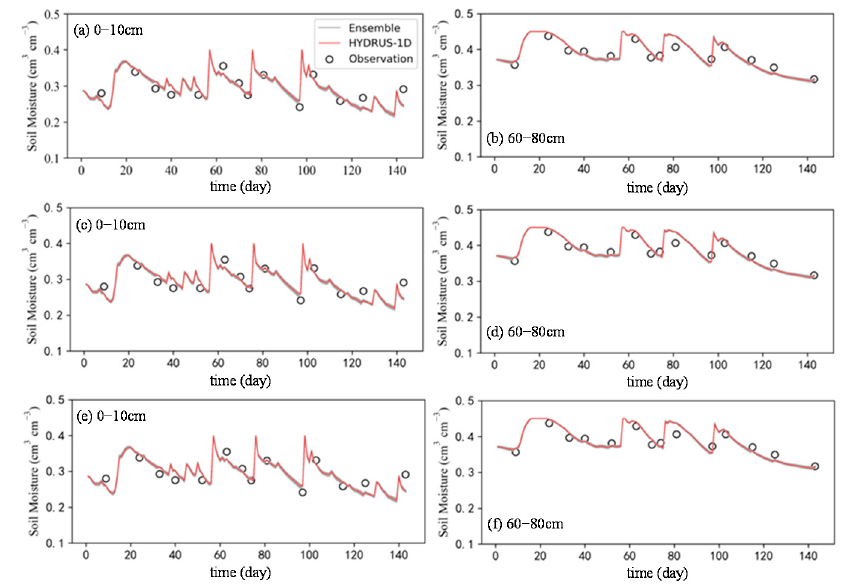
Figure 10. Simulated soil moisture at different depths with different initial perturbations of the soil moisture and salinity: ( a ) 0–10 cm, with standard deviations of 0.001 cm 3 cm − 3 for moisture and 0.1 g L − 1 for salinity; ( b ) 60–80 cm, with standard deviations of 0.001 cm 3 cm − 3 for moisture and 0.1 g L − 1 for salinity; ( c ) 0–10 cm, with standard deviations of 0.001 cm 3 cm − 3 for moisture and 1 g L − 1 for salinity; ( d ) 60–80 cm, with standard deviations of 0.001 cm 3 cm − 3 for moisture and 1 g L − 1 for salinity; ( e ) 0–10 cm, with standard deviations of 0.01 cm 3 cm − 3 for moisture and 0.1 g L − 1 for salinity; ( f ) 60–80 cm, with standard deviations of 0.01 cm 3 cm − 3 for moisture and 0.1 g L − 1 for salinity.